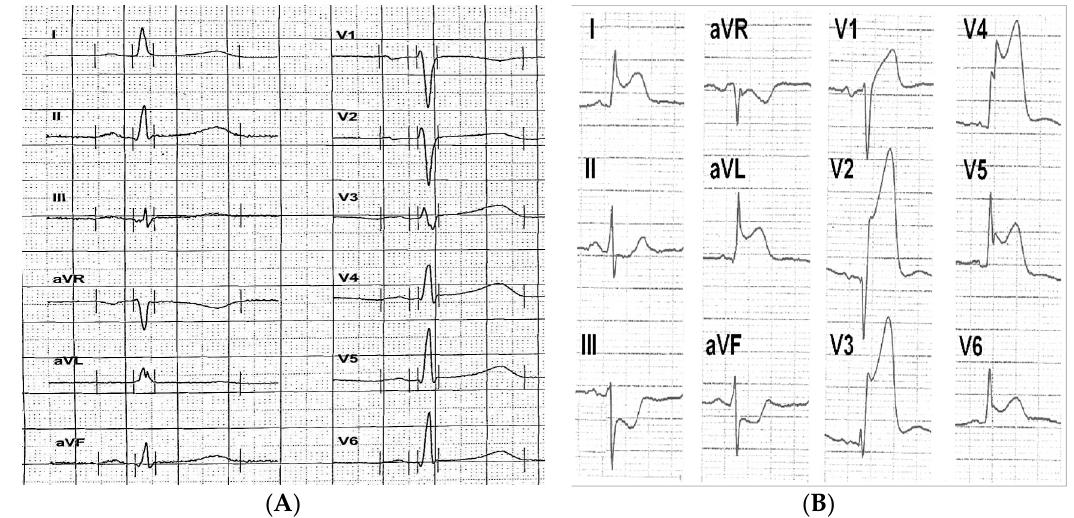
Figure 1. Representative electrocardiograms of ( A ) TTC and ( B ) Anterior ST-segment elevation myocardial infarction (STEMI).